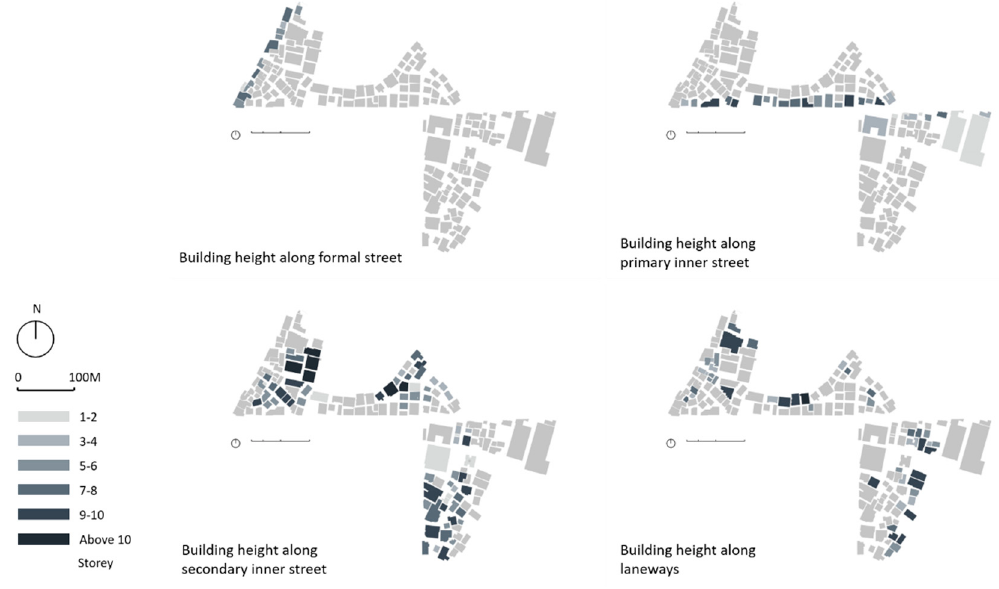
Figure 9. Building heights located in different types of streets.